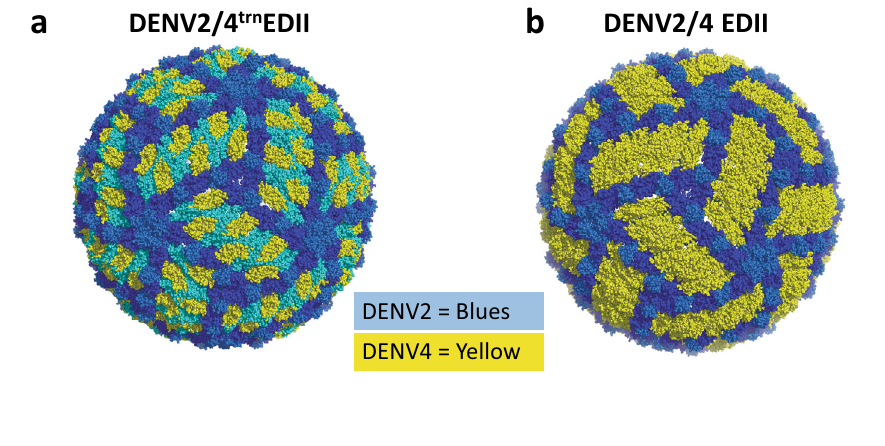
the exception of E89G, which is an essential tissue culture adaptation found in recoveredDENV2/4EDII.ChimericEglycoproteinsfromDENV2/4 trn EDIIandDENV2/ 4EDII with their respective tissue culture mutations are shown in comparison with parental DENV2 and DENV4 sequences. DENV2 amino acids are shown in blue and DENV4are yellow. Amino acidsunique to the chimerashavewhite background. All amino acids not shown are homologous to DENV2 and DENV4. The furin cleavage site in prM is denoted by the red box. Tissue culture (TC) changes are denoted by green boxes. The single amino acid change in EDI is shown in a brown